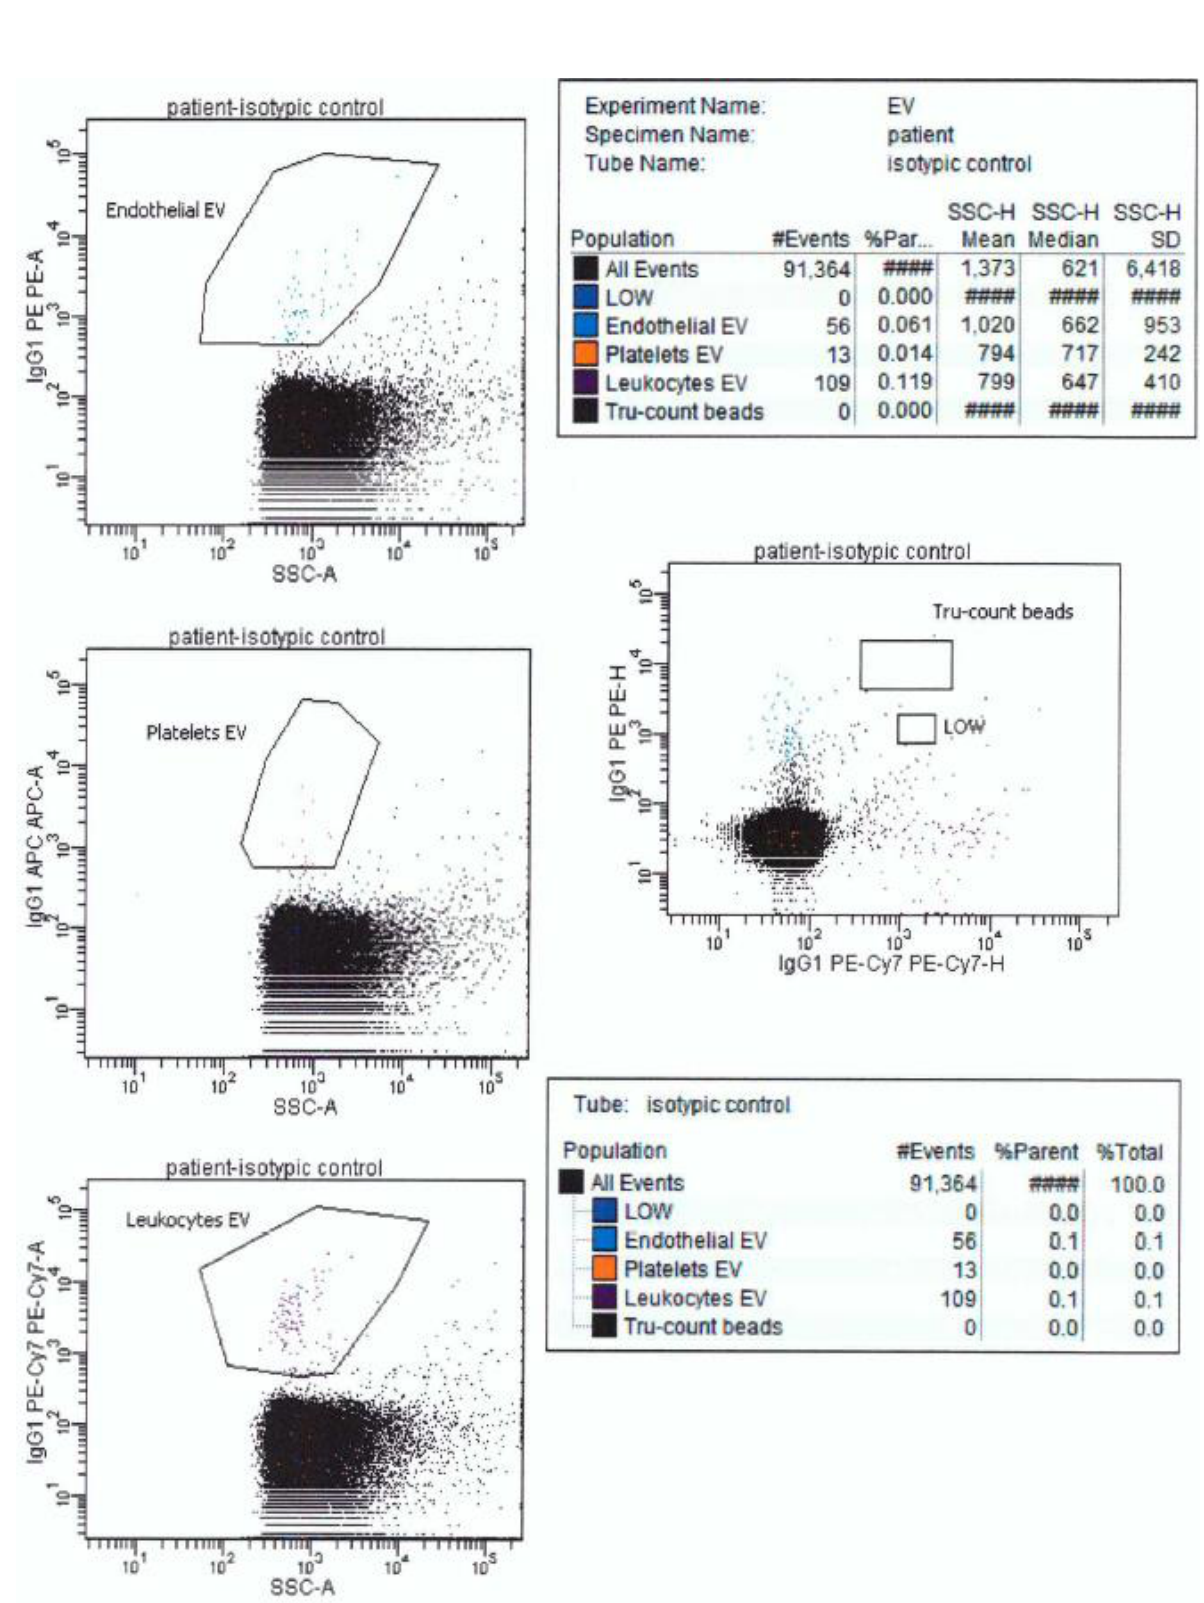
Figure 2. Example of isotypic control and platelets-, endothelial-, leukocytes- EVs with anti-CD42b-APC, anti-CD63-PE, anti-CD45-PE-Cy7 antibodies respectively in Tru-count tube with LOW Tru-count control beads using DIVa 8.0.1 software and FACSCantoII flow cytometer (Becton, Dickinson and Company) (own results, unpublished). As an internal control of the assessments of the absolute number of particles, manufacturer controls were used (LOW control beads were used because the number of detected particles was